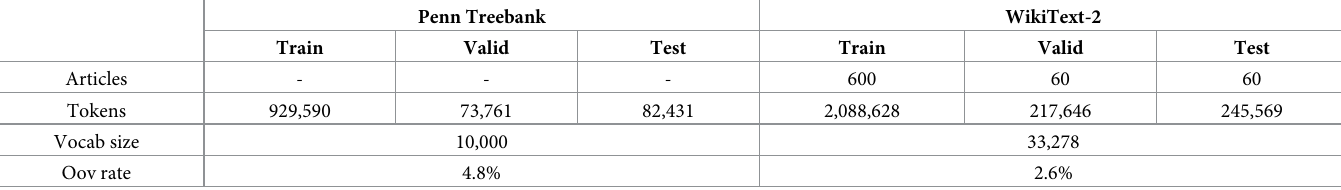
Note: The out of vocabulary (OoV) rate notes what percentage of tokens have been replaced by an < unk > token. The token count includes newlines which add to the structure of the WikiText